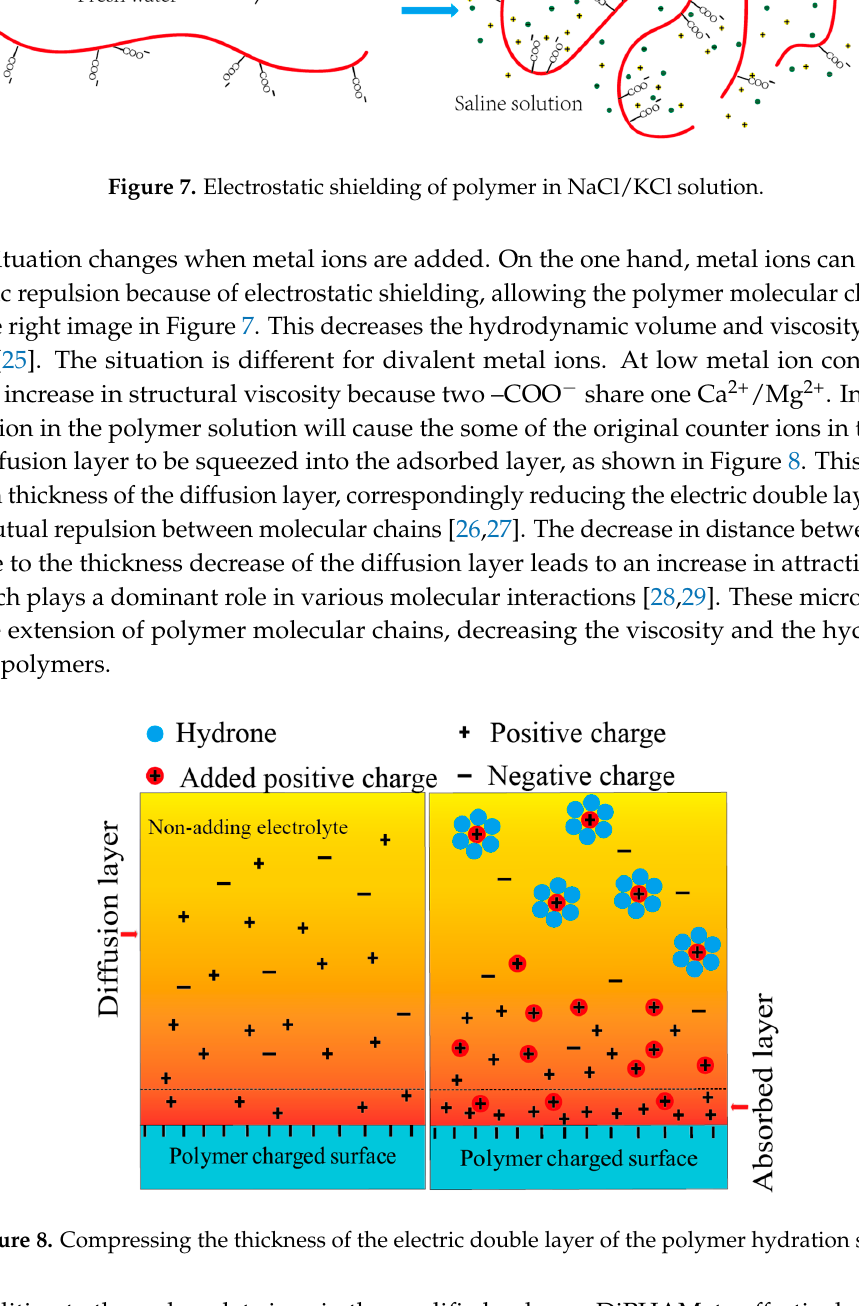
Figure 8. Compressing the thickness of the electric double layer of the polymer hydration